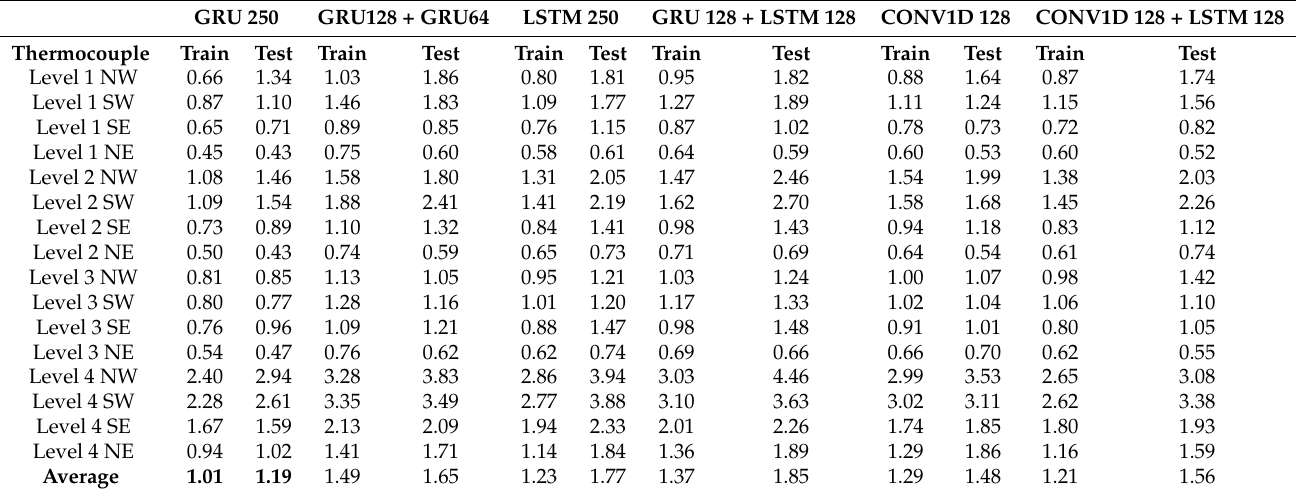
Table 4. RMSE comparison of six different deep learning models for each one of the 16 output thermocouples in the training and test sets. (The percentage of data split in train set was 90% and the remaining 10% was used for test set.) GRU 250 GRU128 + GRU64 LSTM 250 GRU 128 + LSTM 128 CONV1D 128 CONV1D 128 + LSTM 128